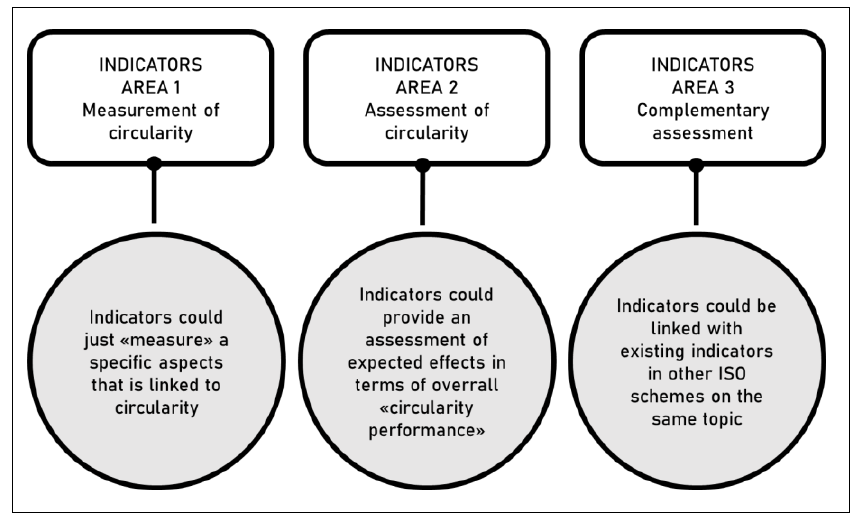
Figure 7: Role of Indicators within the Emerging